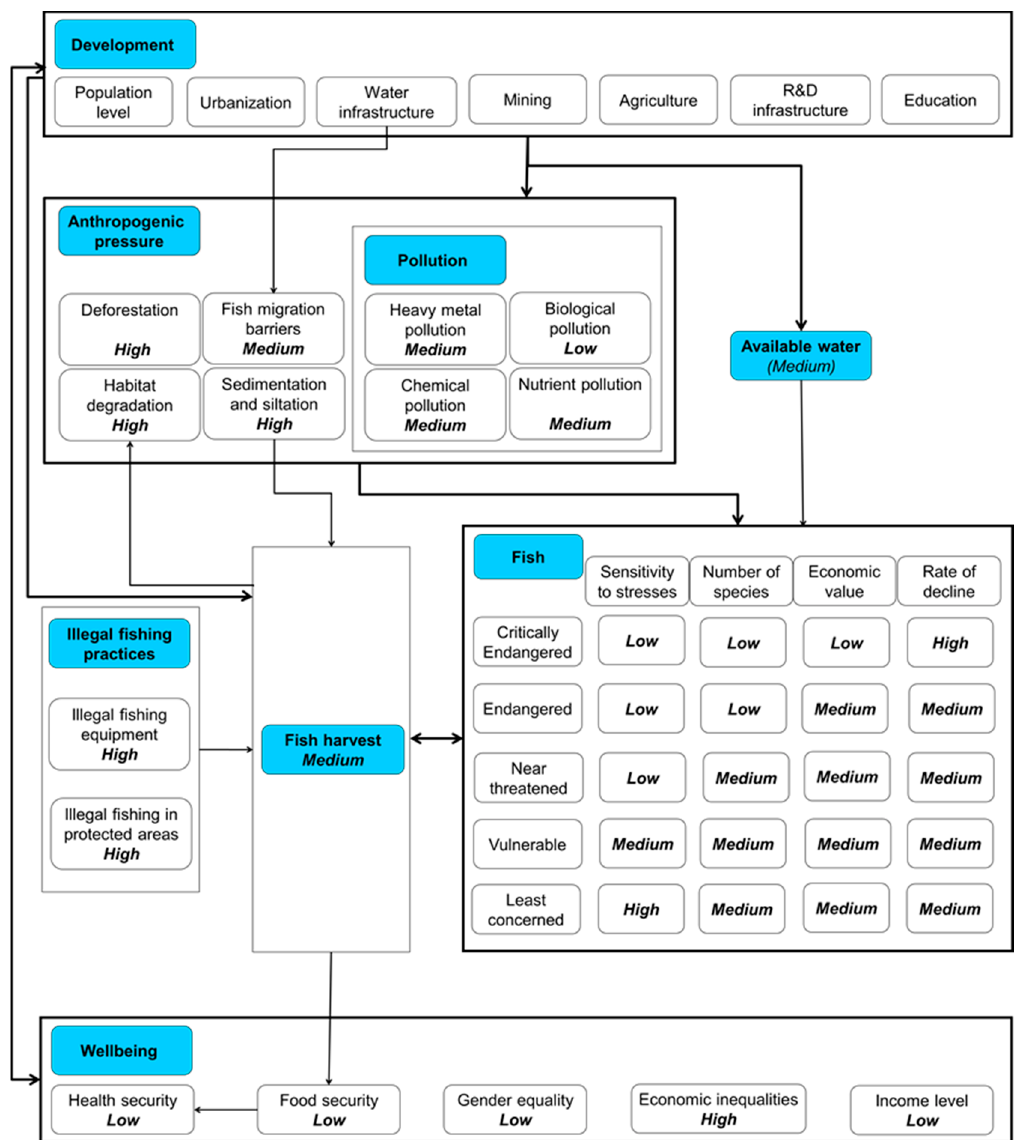
Figure 3. Causal map from the strategic simulations. The arrows show the interdependencies of the most important environmental and socio-economic factors of the Nakambe basin/BF system. The categories in italic and bold are the levels assigned by the participants to describe the current situation. The initial rating from 1 to 5 was recoded into Low (1–2), Medium (3), and High (4–5). R&D: Research and development.